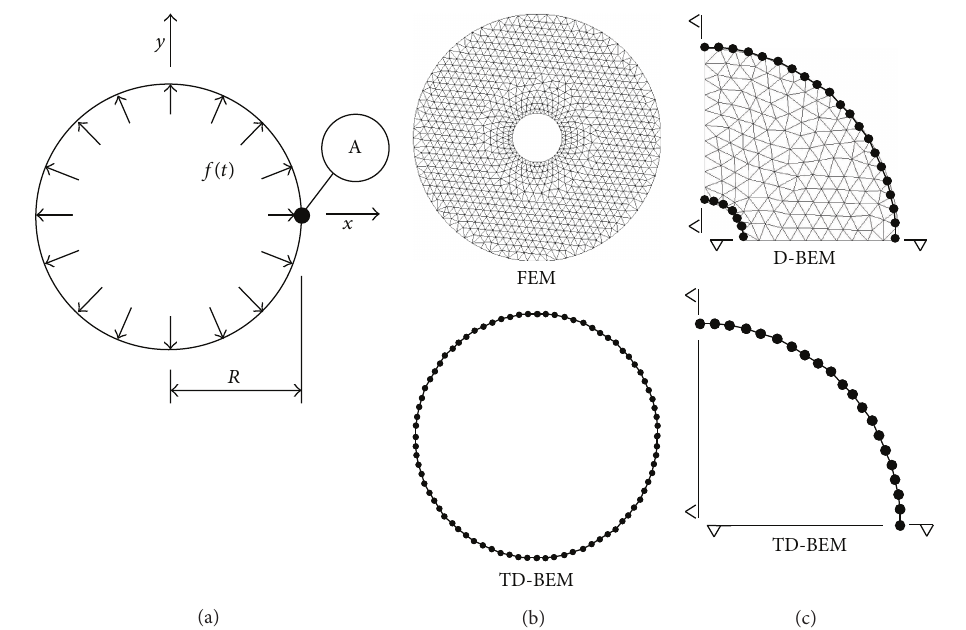
Figure 11: (a) Sketch of the circular cavity; (b) FEM-BEM discretization; (c) BEM-BEM discretization.